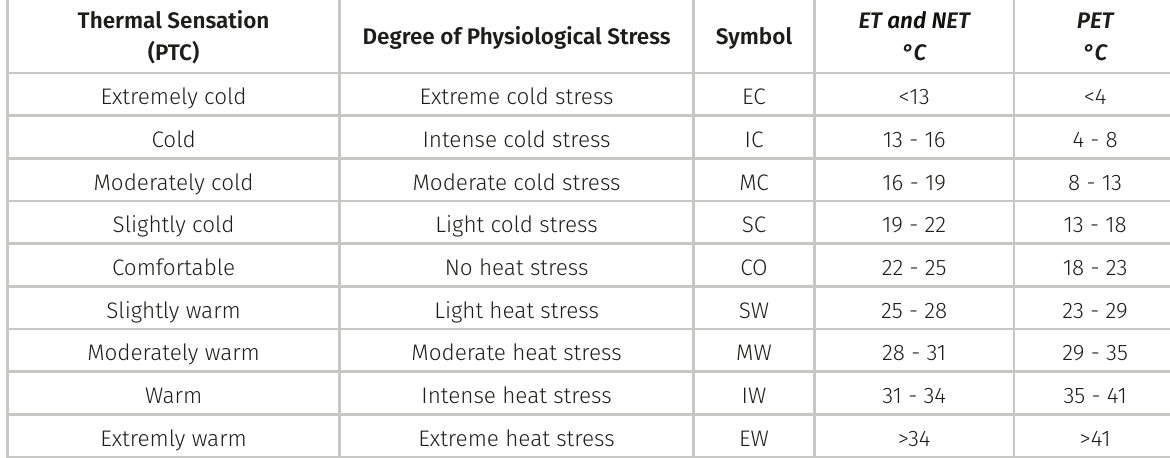
Adapted from Pallotta et al.